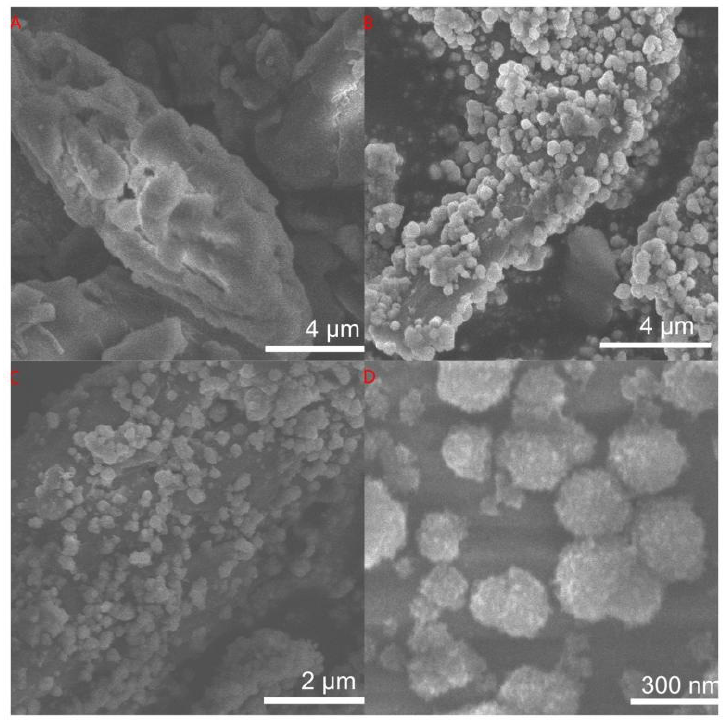
Figure 2. SEM images of the ( A ) RH and ( B – D ) TiO 2 -2RH. In Figure 3, FTIR spectra of RH and TiO 2 -RH composite are presented. Vibration absorption band of TiO 2 -RH composite between 1400 and 450 cm − 1 belongs to characteristic mode of TiO 2 . The bands at 610 and 1390 cm − 1 are ascribed to Ti − O and Ti − O − Ti stretching, respectively [11–13]. Strong − OH stretching (3300–3500 cm − 1 ) in TiO 2 and TiO 2 -RH composite may be due to the adsorbed water [12]. FT-IR spectrum of RH presents a vibrational band at 2916 cm − 1 , which is assigned to C − H stretching; while the band at 1628 cm − 1 is indexed to C=C stretching. The band between 1387–1016 cm − 1 may be caused by C − O stretching and C=C bending, and such vibrational peaks mostly belong to cellulose, lignin, and biopolymers [11].